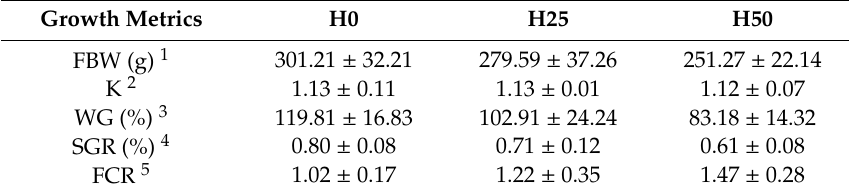
Table 3. Growth response of rainbow trout fed the experimental